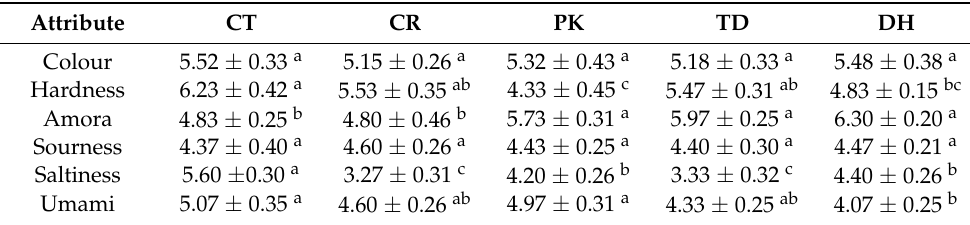
Table 6. Sensory evaluation of the control and reduced-salt dry sausages with and without yeast inoculation after a 12-day fermentation